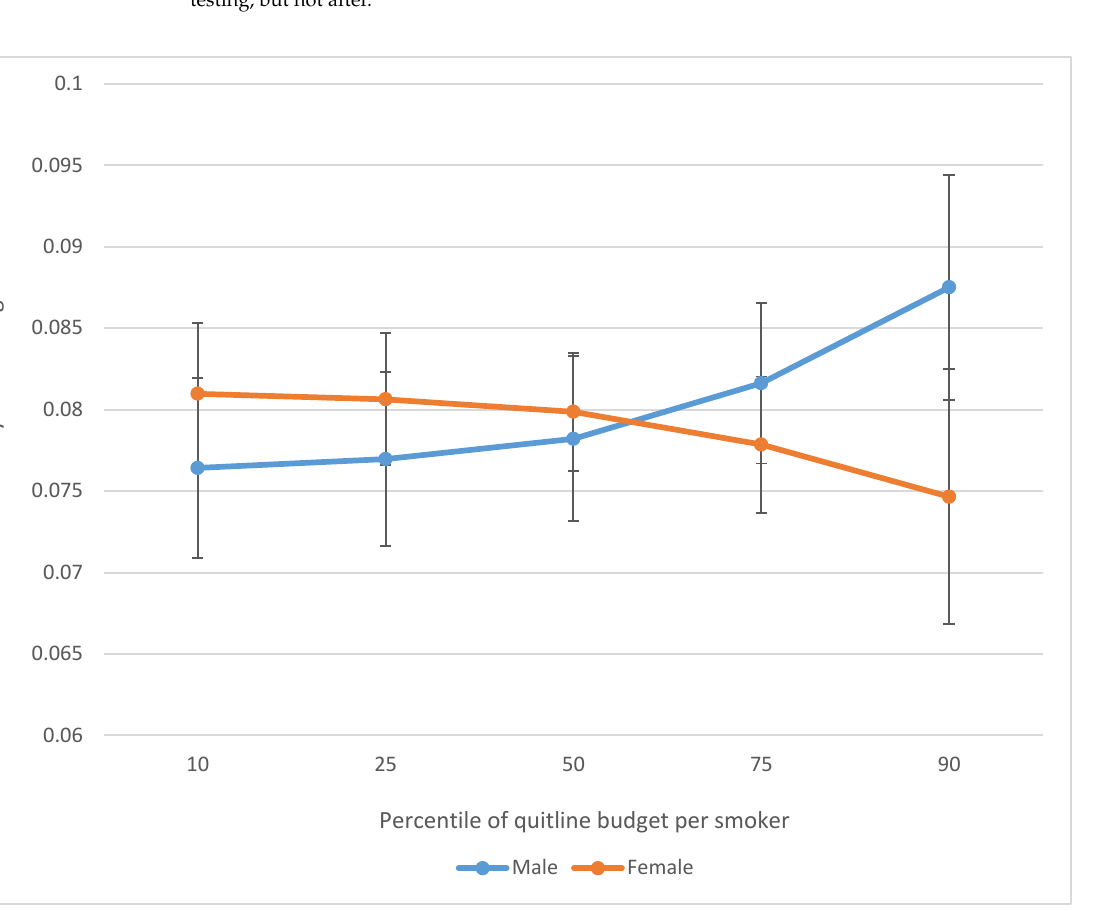
Table 3. Unadjusted multiplicative p -values a associated with interaction terms between quitline exposure variables and sociodemographic variables for 90-day smoking cessation.